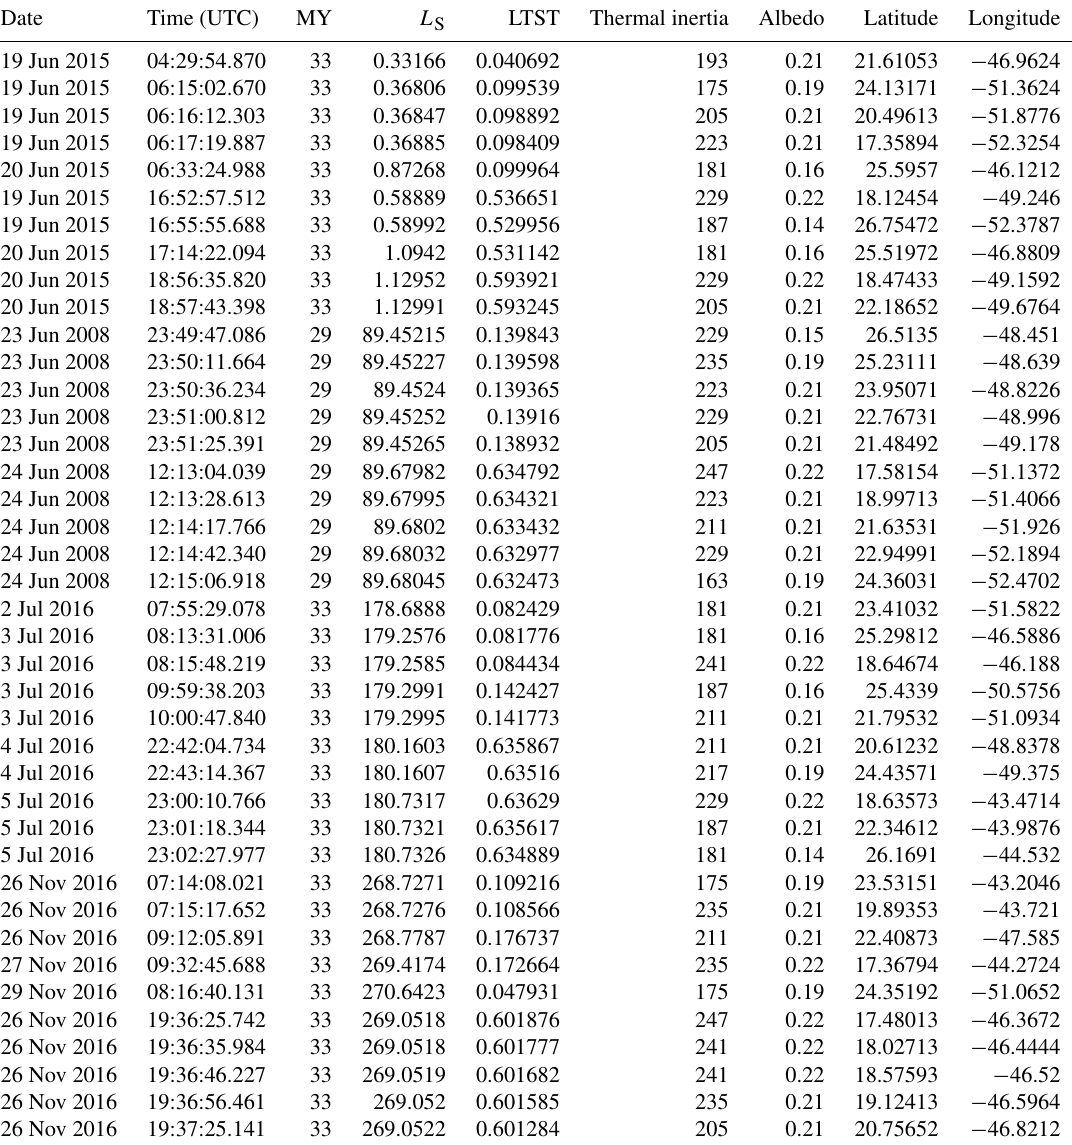
Table A1. MCS sounding details, thermal inertia and albedo for the VL-1